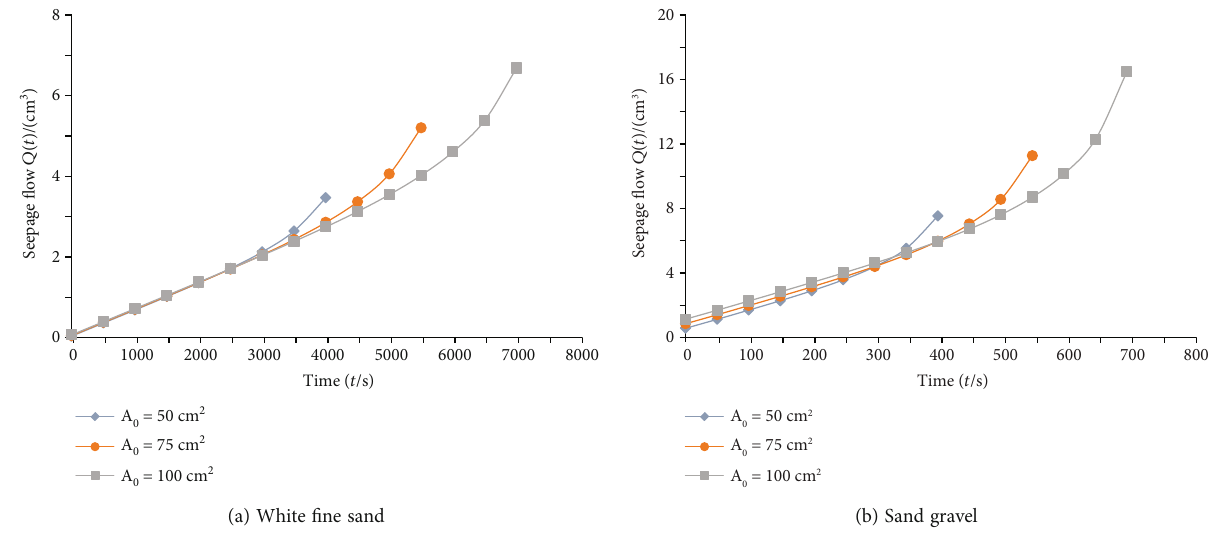
Figure 6: Variation curve between seepage fl ow and time at the free surface of soil with di ff erent A